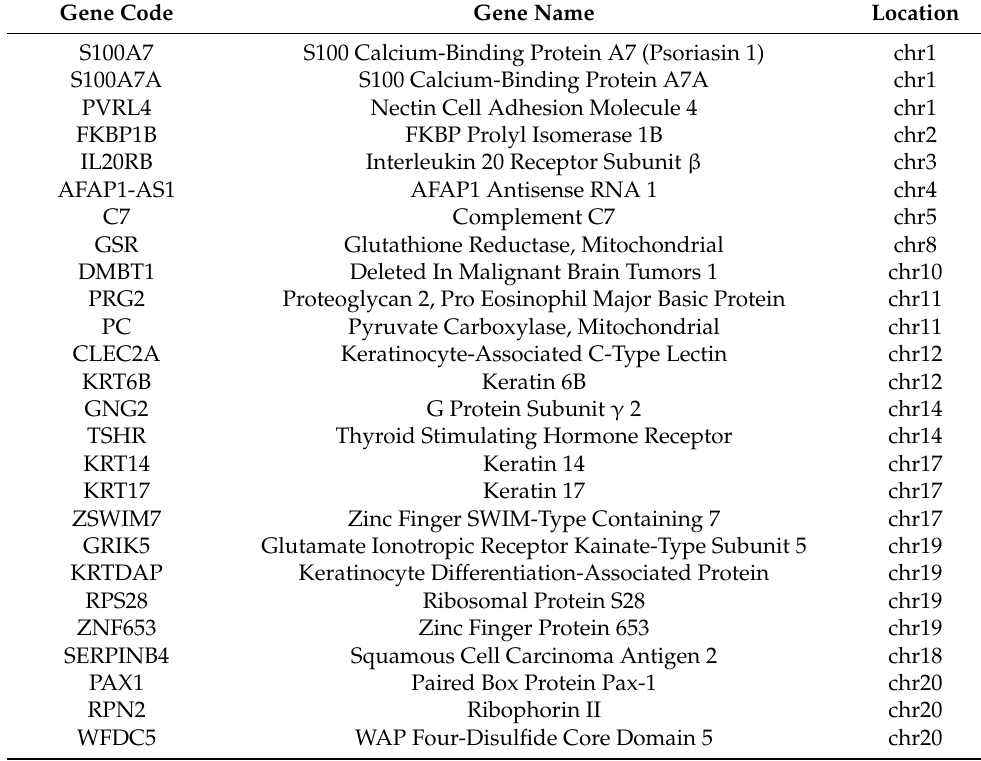
Table 6. The 26 genes in the ensemble meta-classifier with soft